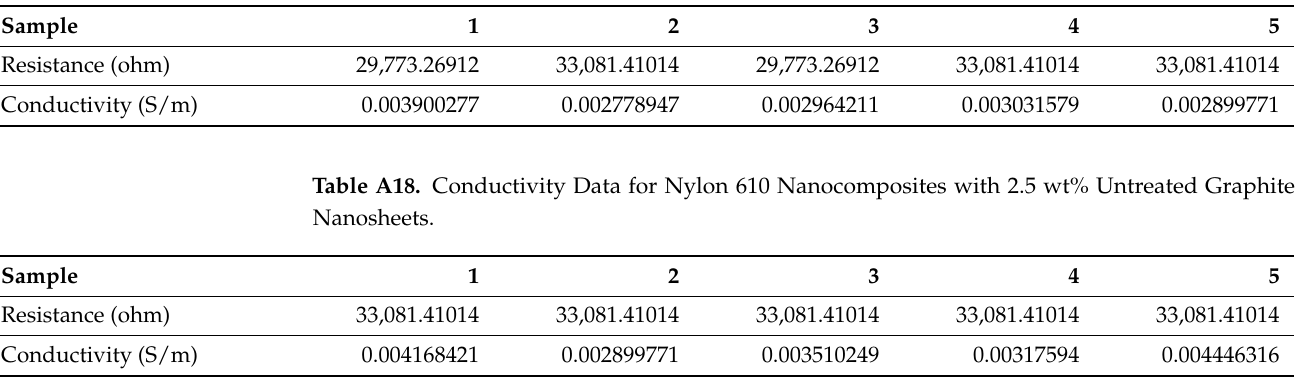
Table A17. Conductivity Data for Nylon 610 Nanocomposites with 1.5 wt% Untreated Graphite Nanosheets.